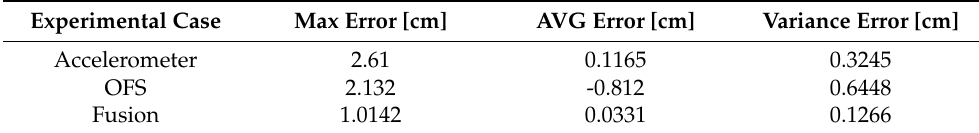
Table 1. Numerical data of distance estimation error calculated for each experimental case separately. Experimental Case Max Error [cm] AVG Error [cm] Variance Error [cm] Accelerometer 2.61 0.1165 0.3245 OFS 2.132 -0.812 0.6448 Fusion 1.0142 0.0331